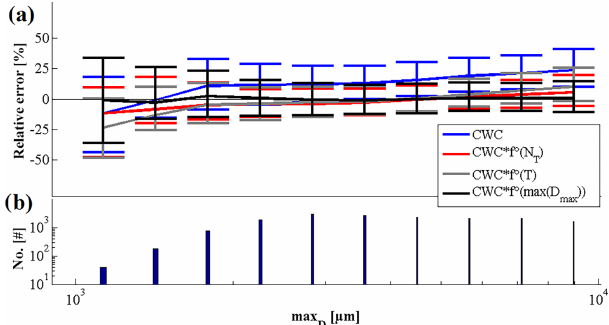
Figure 5. Same as Fig. 3 but represented as a function of the maxi- mum size of hydrometeors max( D max ) on the x